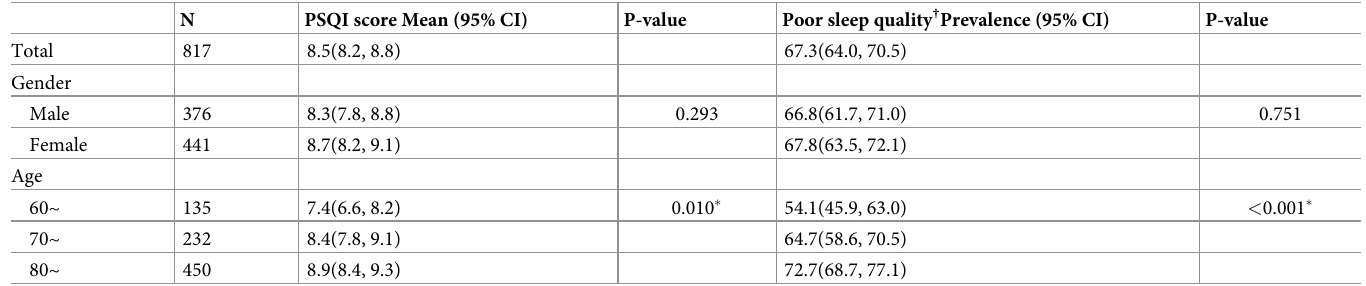
The Andersson’s Excel was used to detect interactions between risk factors for sleep quality and calculate their effect size on poor sleep quality. Thus, interactions were detected between the following variables: older age and anxiety symptoms, with a RERI of 2.83 (95% CI: 0.13, Table 2. The PSQI global score and the prevalence of poor sleep quality among the elderly in the nursing homes stratified by age and